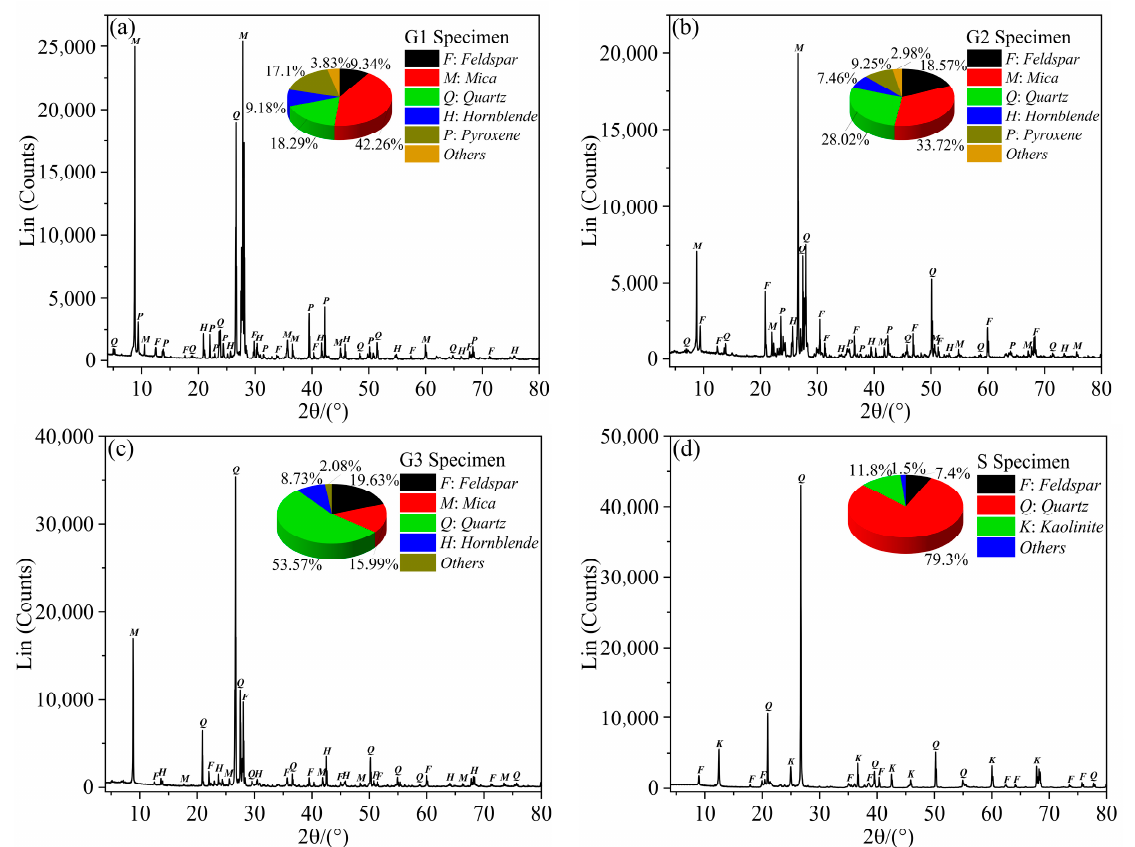
Figure 4. X-ray diffraction (XRD) patterns of rock specimen: ( a ) G1 specimen; ( b ) G2 specimen; ( c ) G3 specimen; ( d ) S specimen.